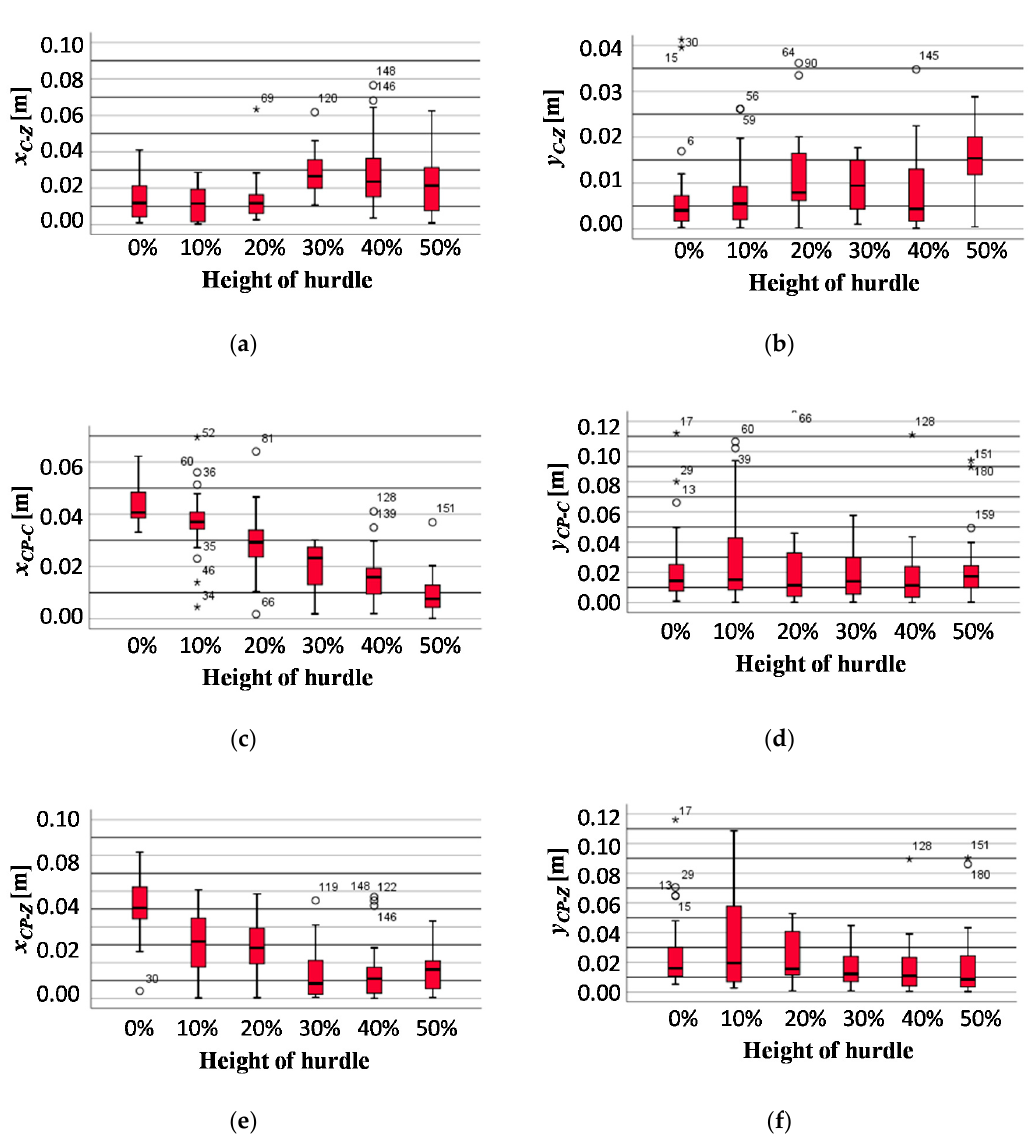
Figure 12. RMSE results of di ff erence values of COG, ZMP and CP according to the height percentage of lower limb (0%: Case 1; 10%: Case 2; 20%: Case 3; 30%: Case 4; 40%: Case 5; 50%: Case 6): ( a ) x COG — x ZMP ; ( b ) y COG — y ZMP ; ( c ) x CP — x COG ; ( d ) y CP — y COG ; ( e ) x CP — x ZMP ; ( f ) y CP — y ZMP